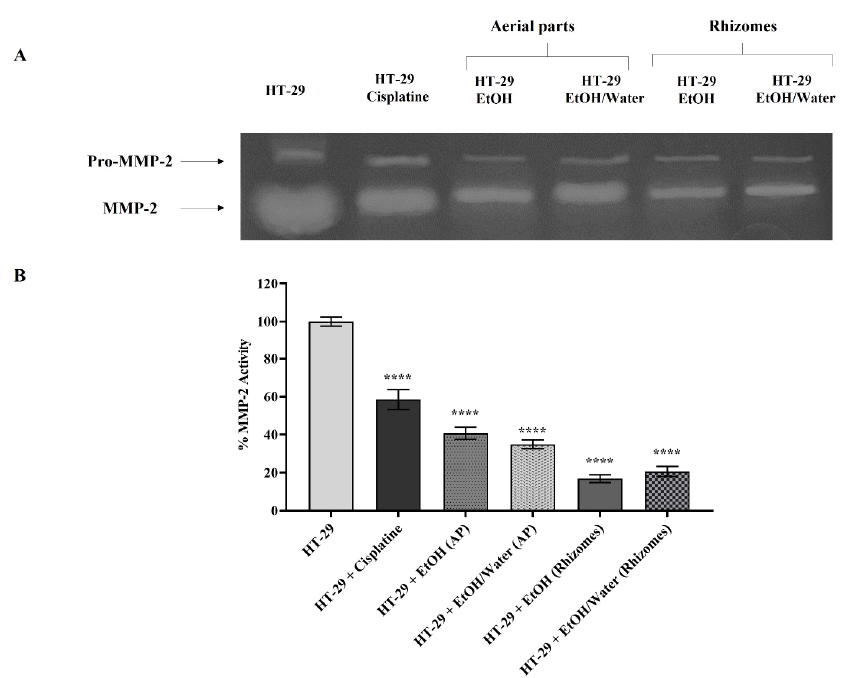
Figure 8. Detection of MMP-2 enzyme activity by gelatin zymography in HT-29 cell line treated with different Primula auriculata extracts and positive control cisplatin. Lytic white bands on the dark background of the gel stained with Coomassie brilliant blue were captured by ChemiDoc (in ( A )). For the detection of MMP-2 enzyme activity, untreated HT-29 cells were selected as the control, and the band intensity was measured with Image J. In the statistical analysis, p ≤ 0.0001 is presented with **** (in ( B )).